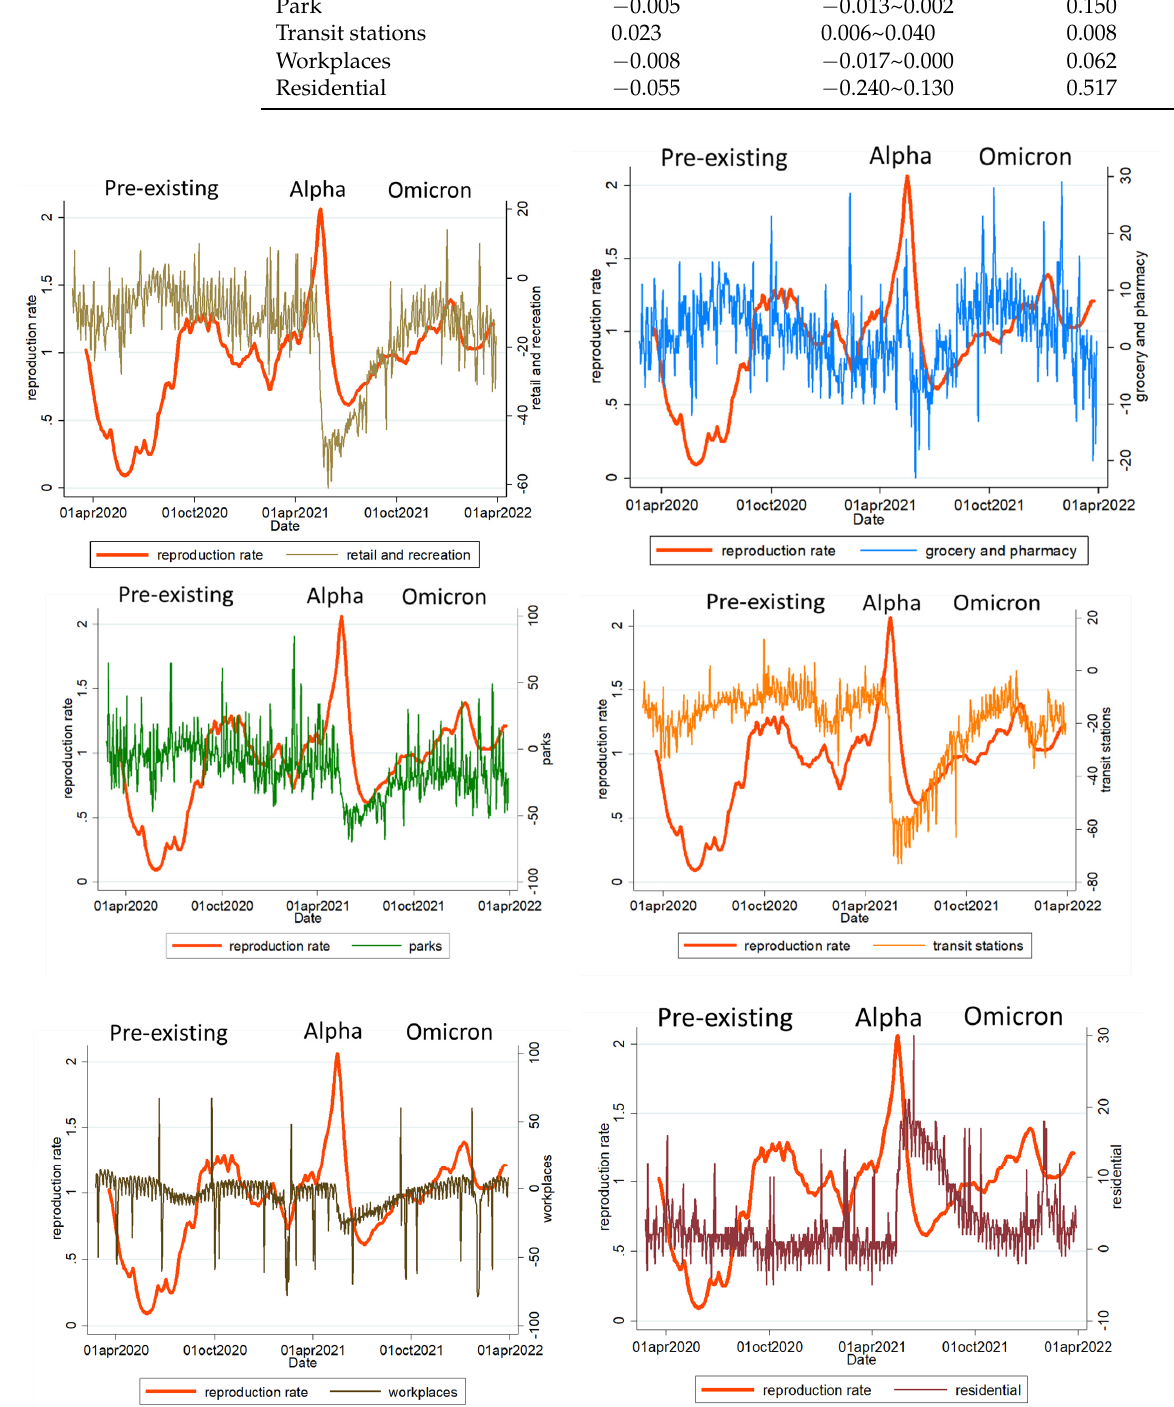
Figure 3. The relationship between changes in the population visits of various places and the 7-day rolling average reproduction rate in Taiwan during the main three waves COVID-19 epidemics.